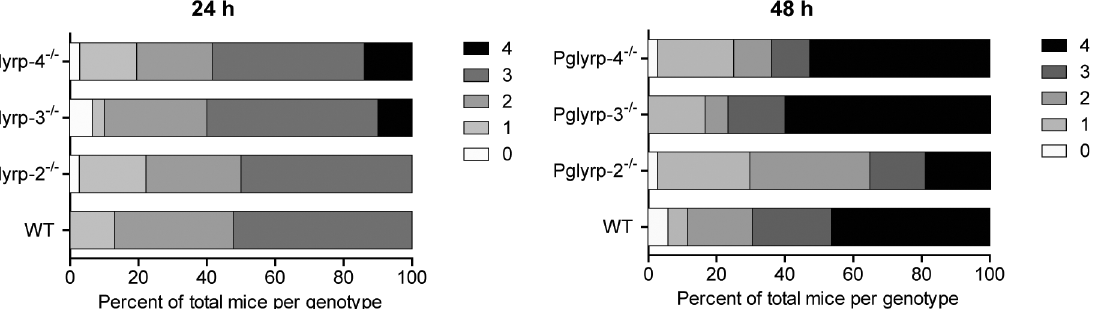
Fig 1. Clinical score frequencies. Clinical disease scores were given in a blinded manner (A) 24 and (B) 48-hours post infection (h p.i.). Results are shown as percent of animals examined in a total of 5 trials per genotype with each trial containing 6 – 9 animals per genotype. The Pglyrp -2 -/- mice showed clinical scores comparable to WT in the 24 h.p.i group; the Pglyrp -3 -/- and -4 -/- mice had a few animals with maximal scores by 24 h.p.i suggesting escalated disease. By 48 hours the Pglyrp -2 -/- mice showed reduced clinical scores.